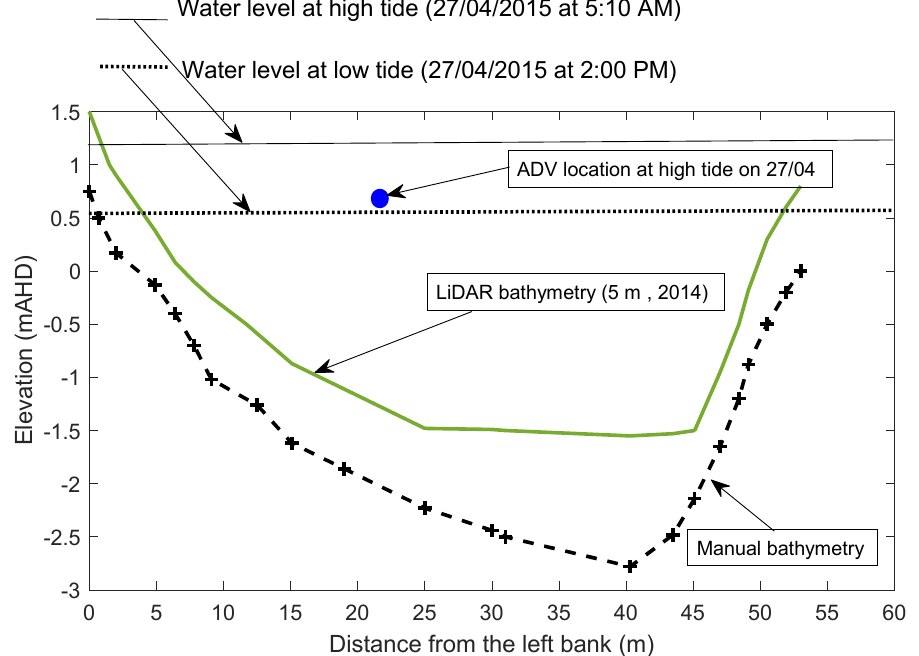
Figure 2. Surveyed transect and 5 m, 2014 LiDAR bathymetry next to the pontoon near B (in Figure 1). The solid line is the water level at high tide at 5:10 a.m. and the dashed line is the water level at low tide at 14:00 on 27 April 2015.